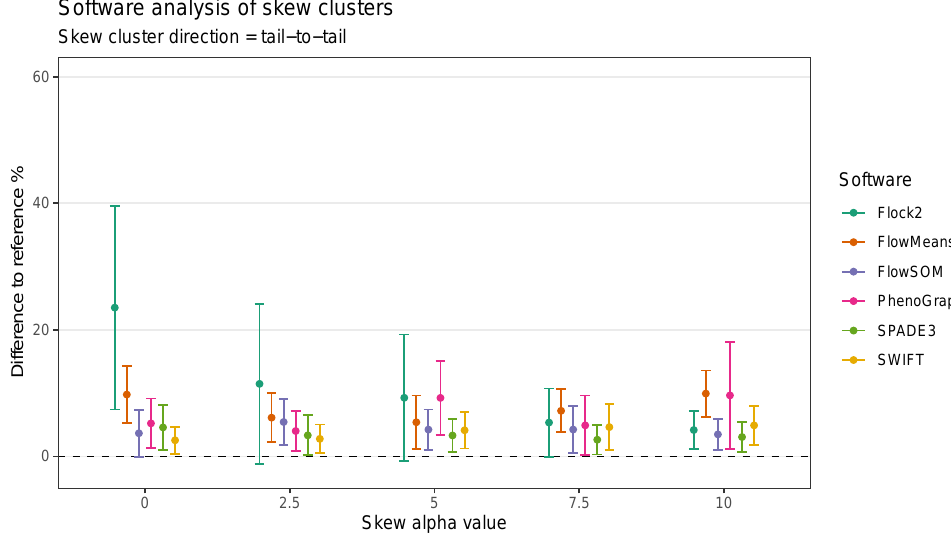
Figure 7. Performance of different software on a dataset with skew cluster orientations facing tail to